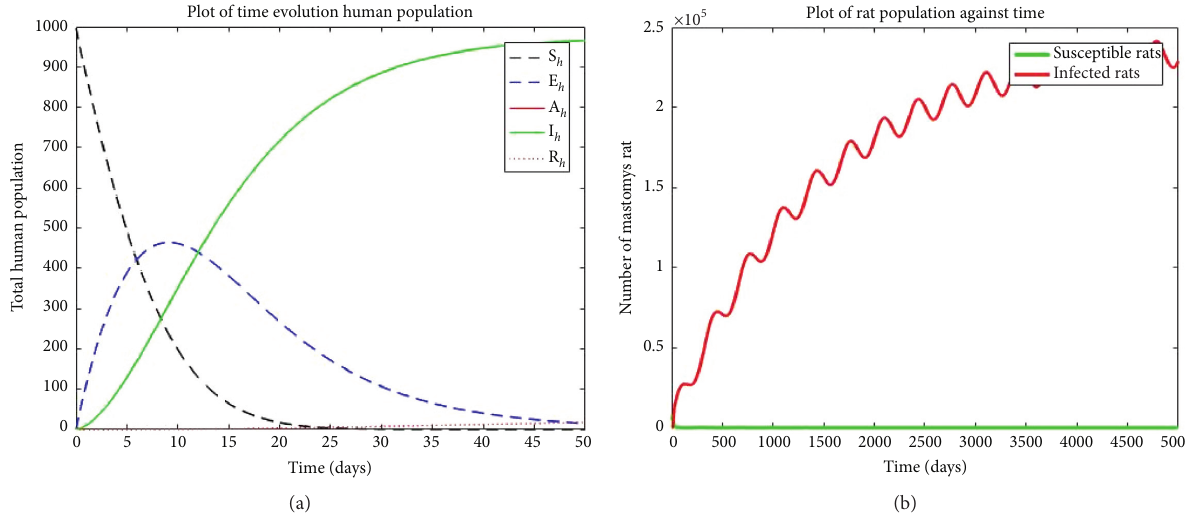
Figure 2: Solution of the Lassa fever periodically forced model (10) with parameter values defined in Table 5. The initial condition is S